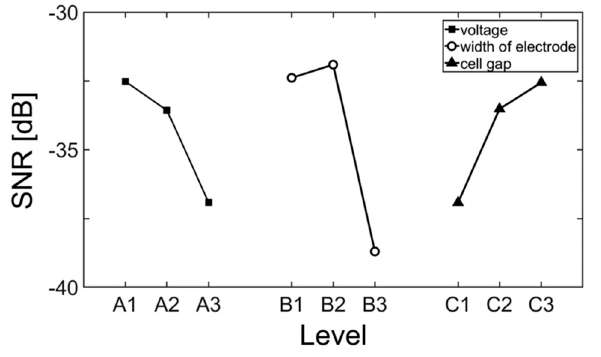
Figure 3. Average SNR according to the levels of each factor.